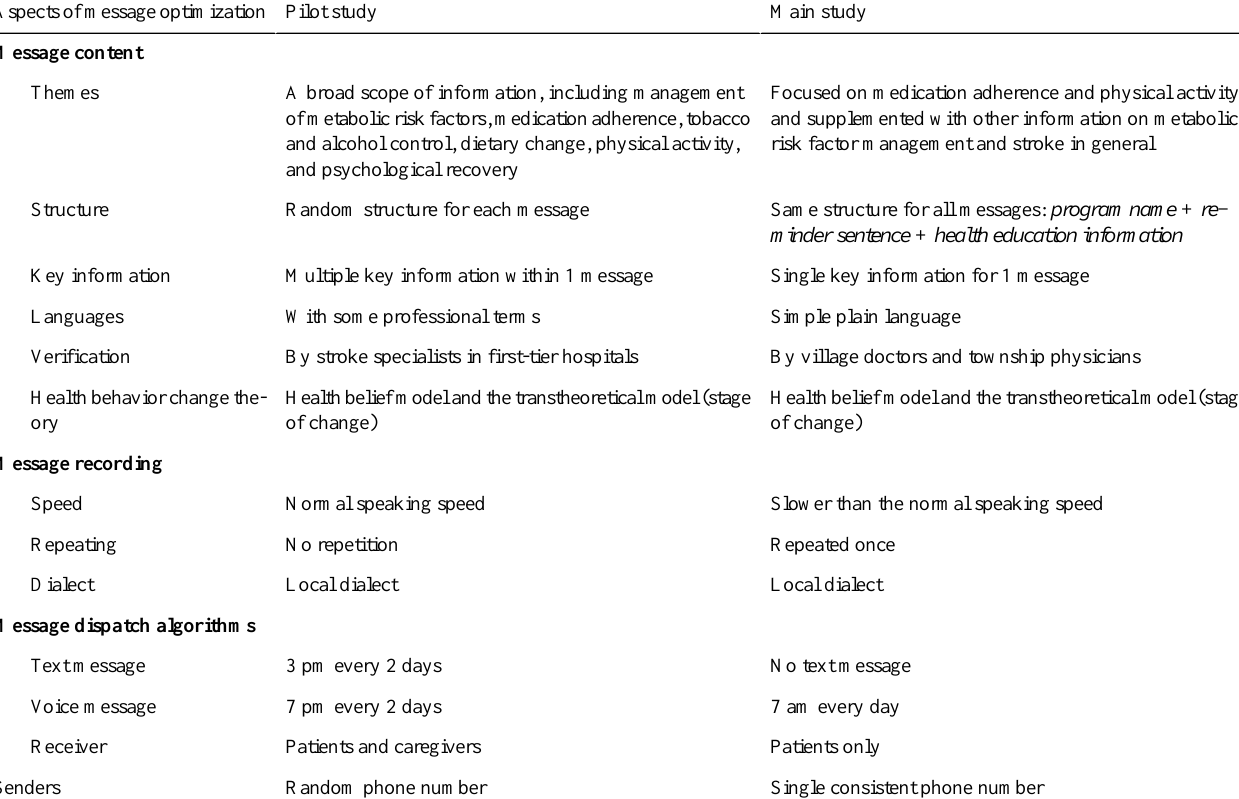
Table 3. Comparison of key aspects of message optimization.